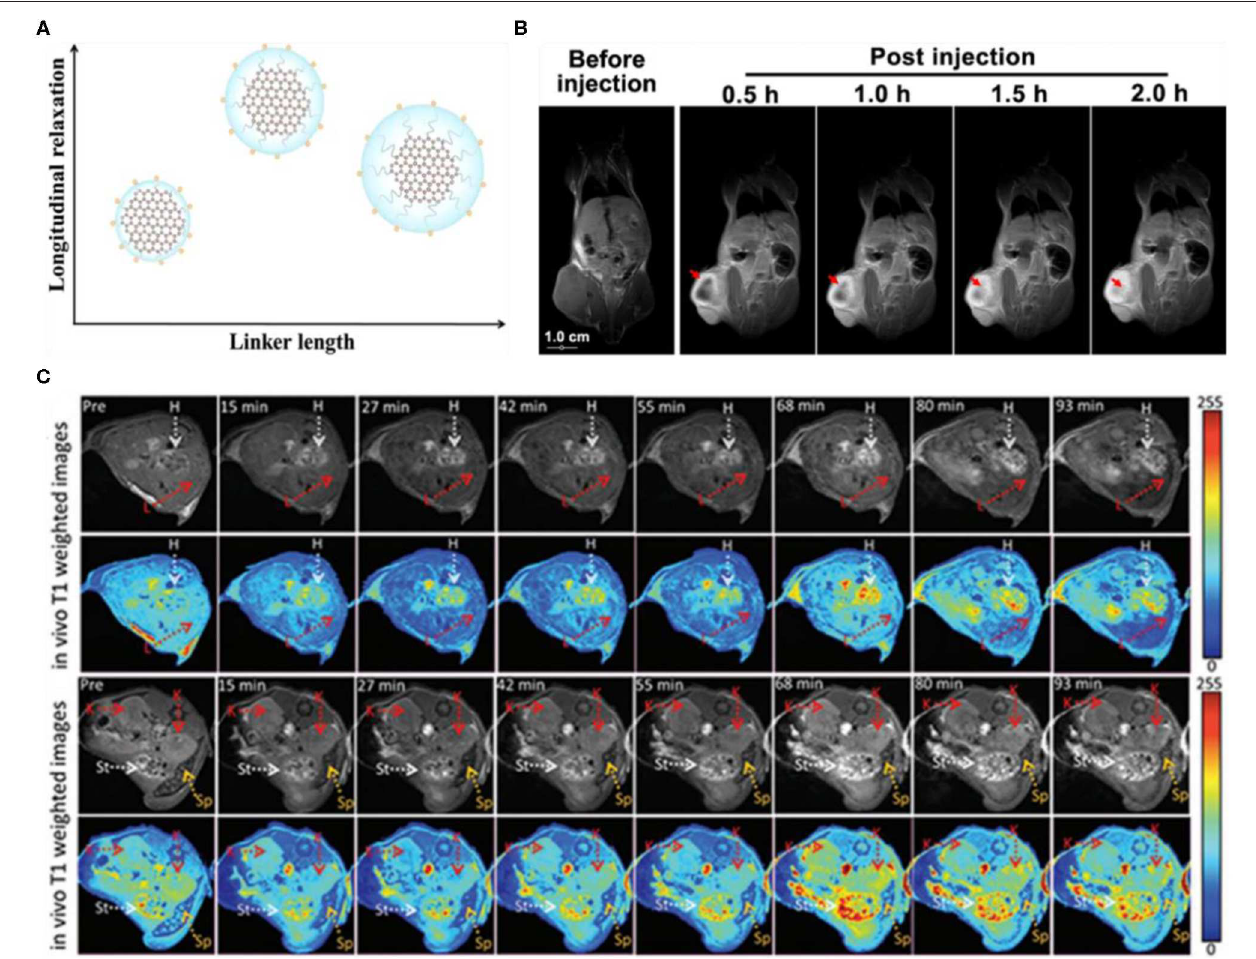
FIGURE 12 | (A) Influence of polyethylene glycol (PEG) chains on the longitudinal relaxivity. (B) In Vivo T 1 -weighted MR images of A549 tumor-bearing mice before and after injection of hyaluronic acid-targeted PGQD (PGQD-HA); reproduced from Yang et al. (2019) with permission from the American Chemical Society. (C) In Vivo T 1 -weighted MR images of mice before and after i.v. injection of B-GQDs; reproduced from Wang et al. (2017) with permission from Wiley. The arrows represented different organs: heart (H), kidney (K), stomach (St), and spleen